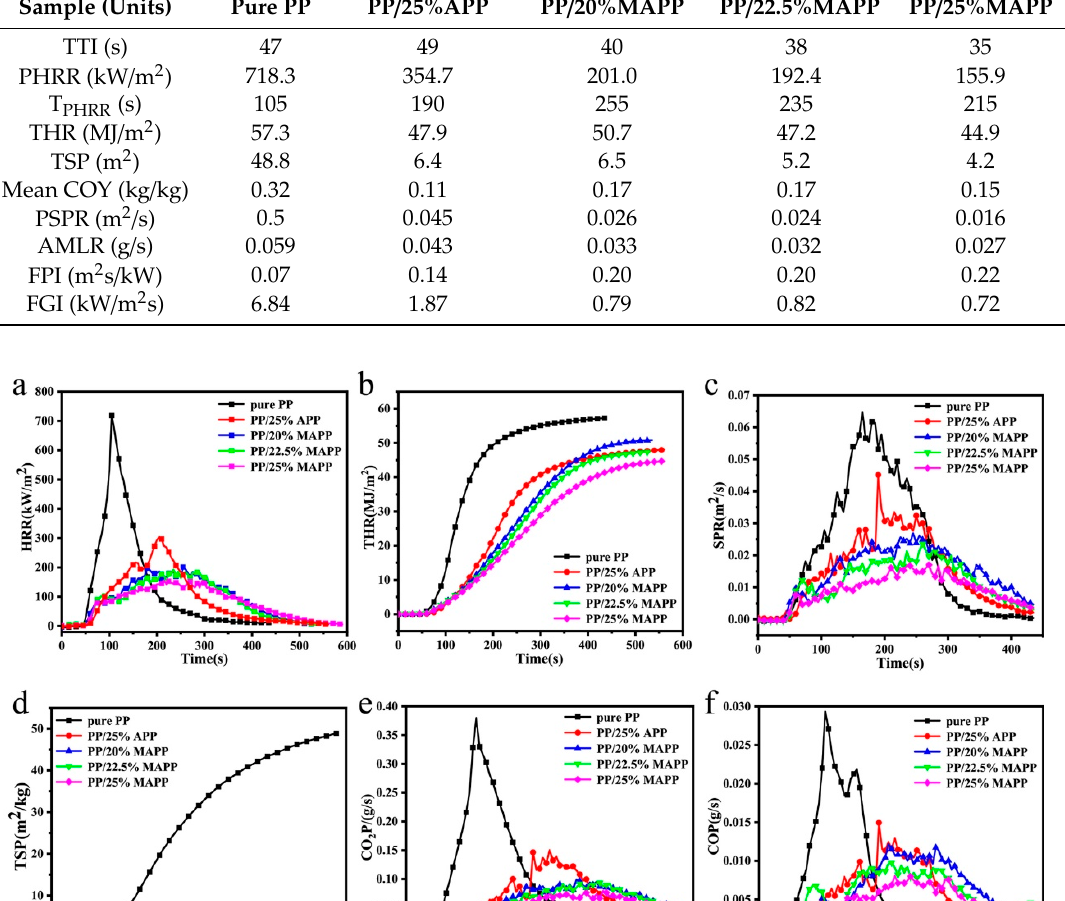
Table 2. Data of the pure PP and its flame-retardant blends during Cone calorimeter combustion.